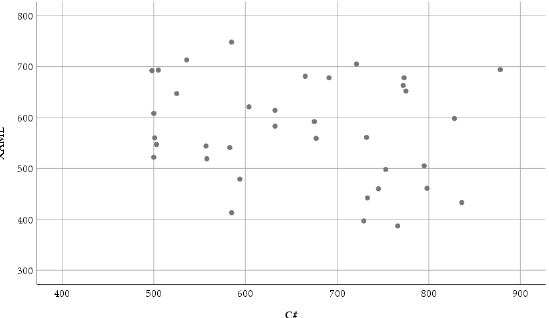
Figure 7. Sca tt er plot of the fi xation duration mean (milliseconds) based on XAML and classic C#.